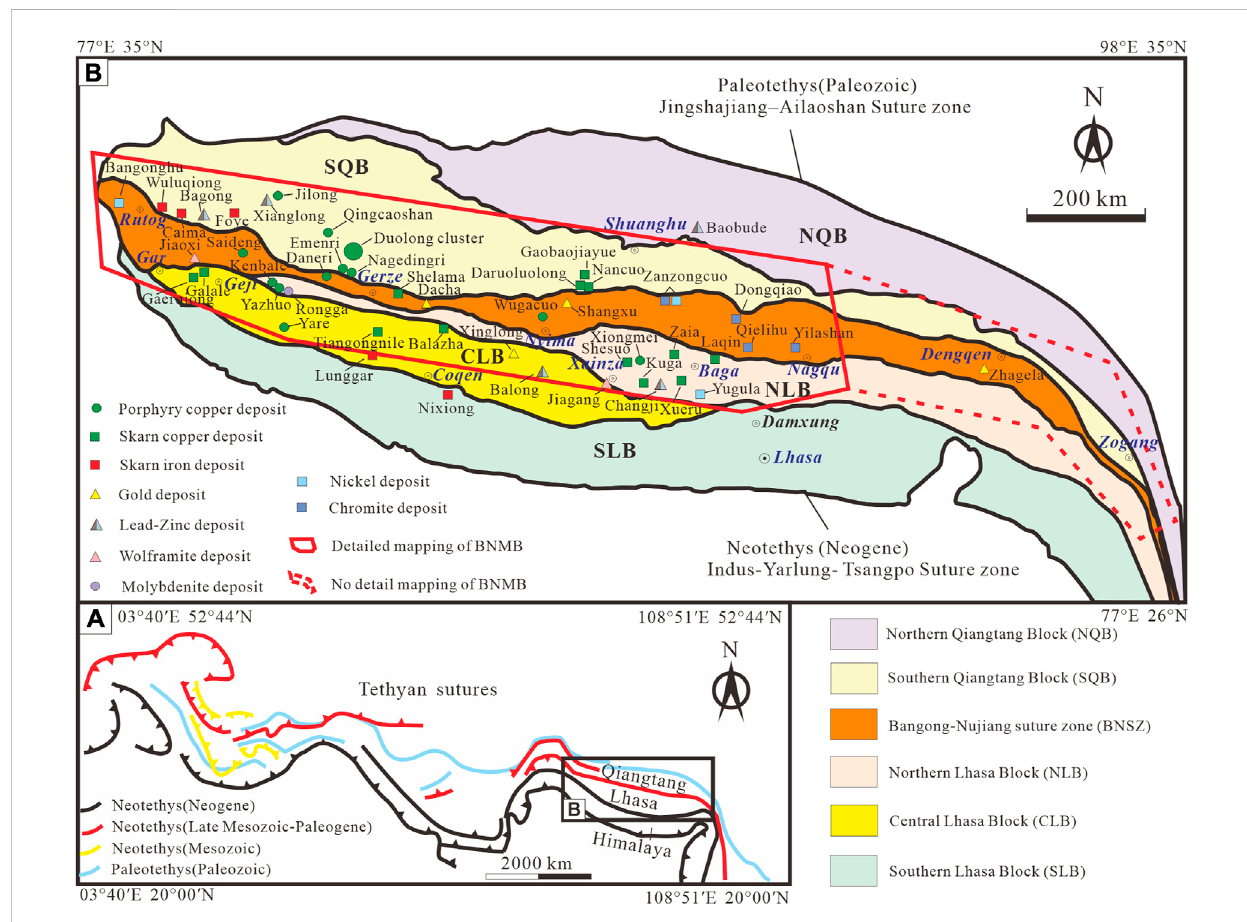
FIGURE 1 (A) Framework of the Tethyan suture zone. (B) Tectonic units and ore deposits in the Bangong – Nujiang metallogenic